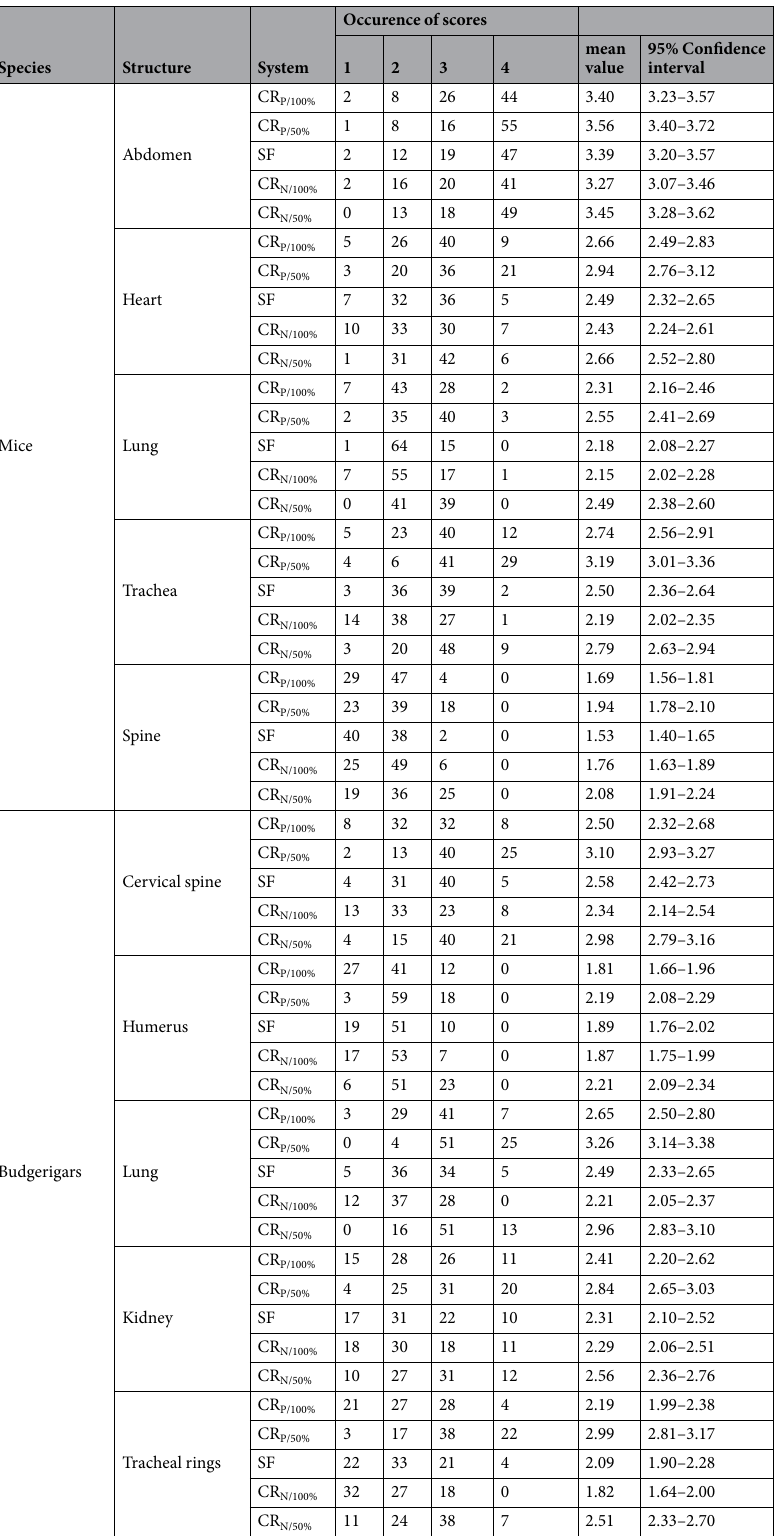
Table 4. Summary of results stating the occurrence of scores and mean